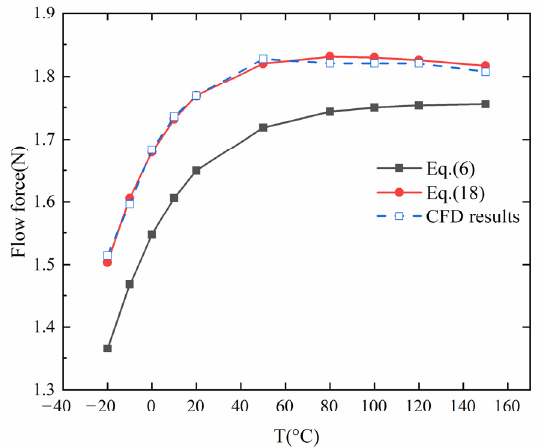
Figure 14. Comparisons between the theoretical and CFD results of the flow force.